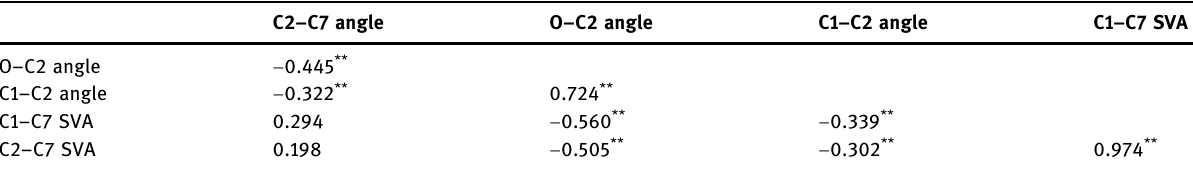
Table 3: Correlation among the cervical sagittal